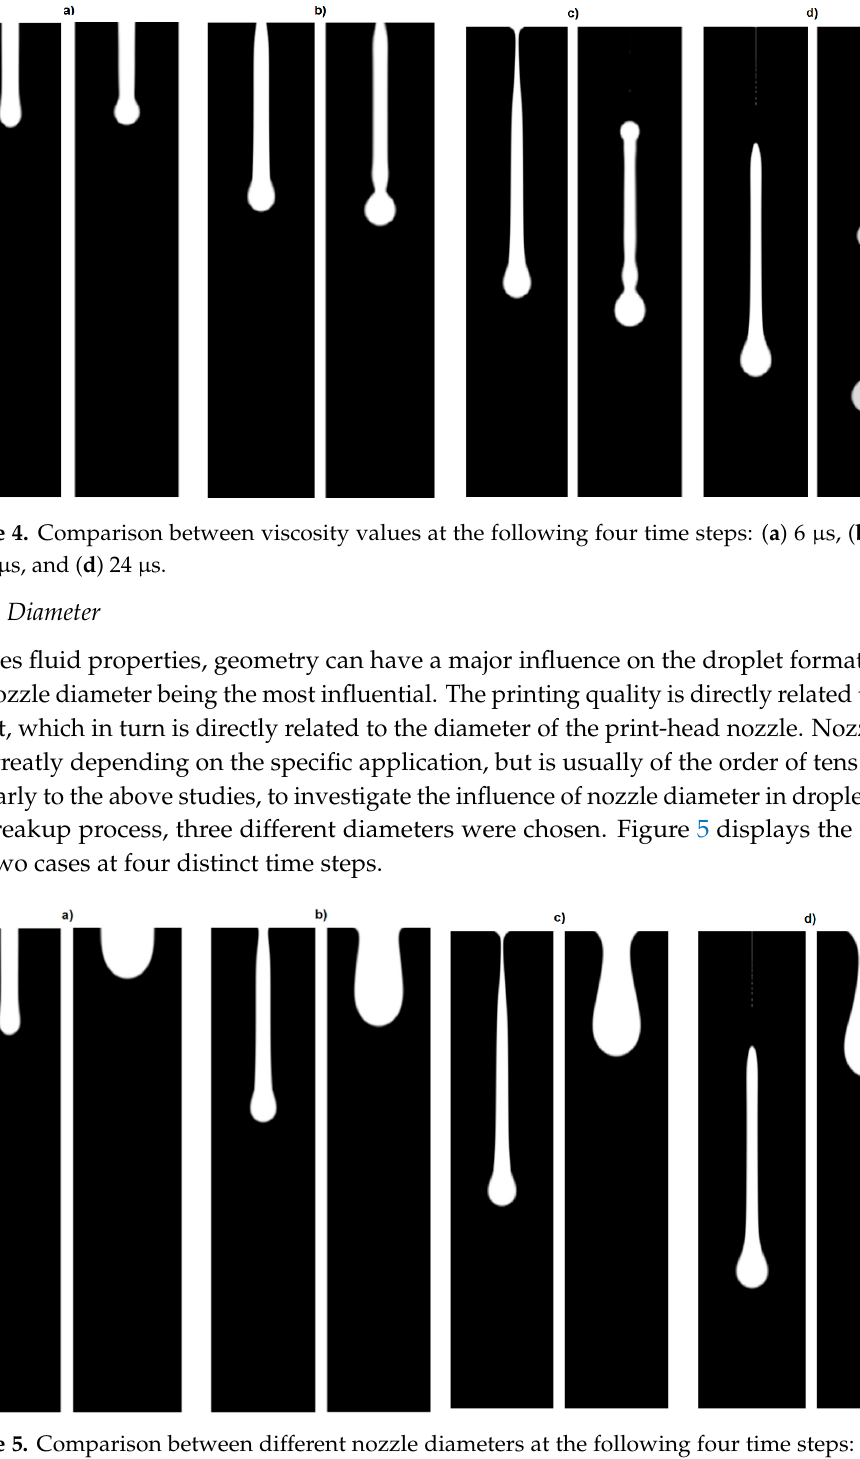
Figure 5. Comparison between different nozzle diameters at the following four time steps: ( a ) 6 μ s, ( b ) 12 μ s, ( c ) 18 μ s, and ( d ) 24 μ s.